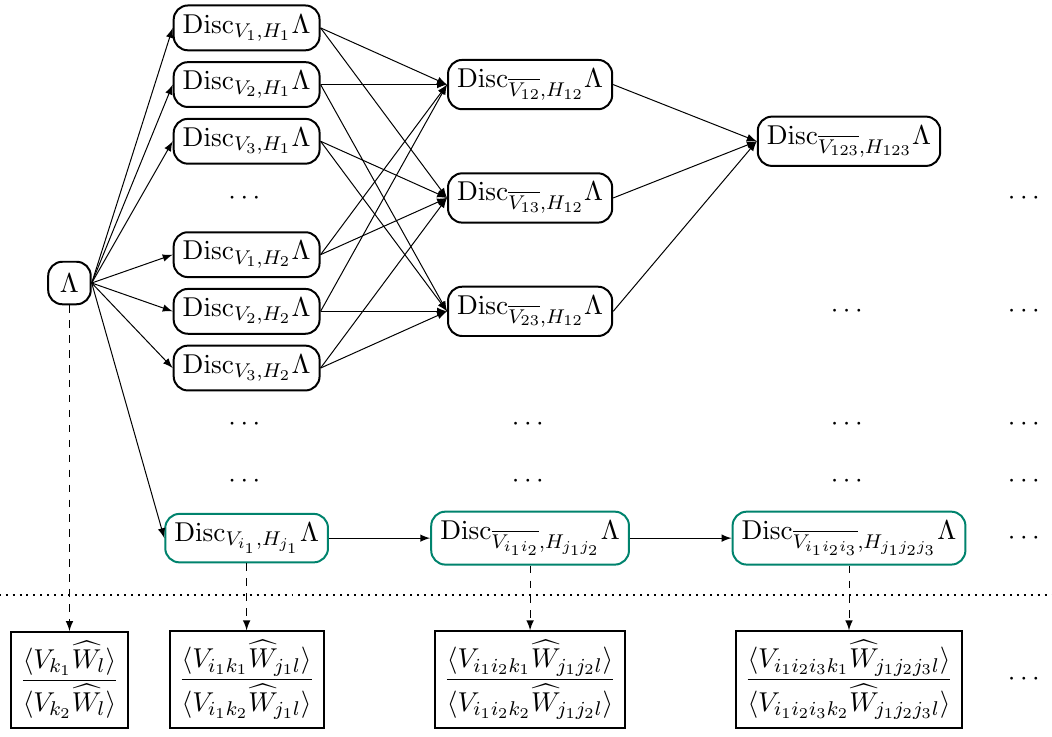
· · · Figure 8 . The web of discontinuities computed recursively from Λ . The green blobs show the generic labeling for the discontinuities obtained at each level. From each discontinuity we determine the set of all its first entries, and it is important to keep track of the projection connections among the discontinuities. In the first entry ratios shown at the bottom we abbreviate V i 1 i 2 ··· i k ≡ V i 1 V i 2 · · · V i k (cid:8)(cid:8) W (cid:8)(cid:8) W and c W (i.e., W with the indicated labels are j 1 j 2 ··· j k ≡ W 1 W 2 · · · j 1 · · · j 2 · · · W n